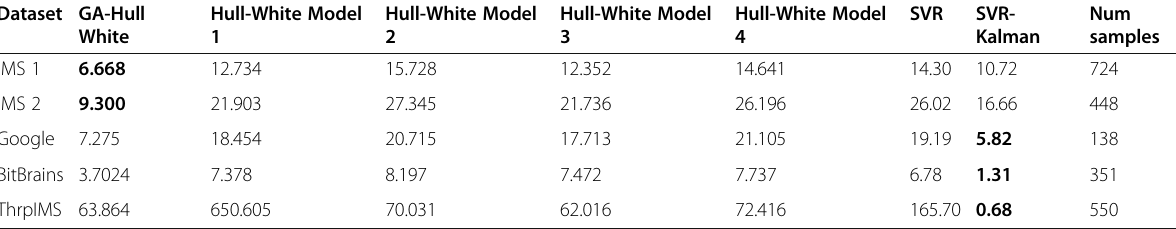
Table 7 Average MAPE of solutions based on 10 simulations Dataset GA-Hull